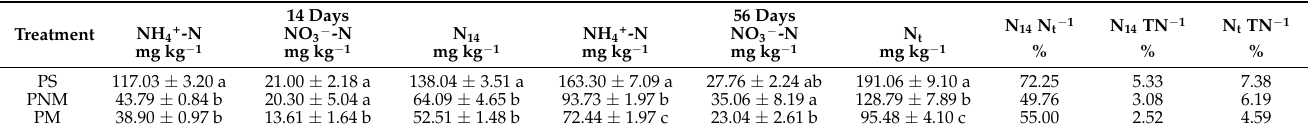
Table 2. The N mineralization for the paddy field, P. plantation without mulching and P. plantation with mulching sites. Treatment